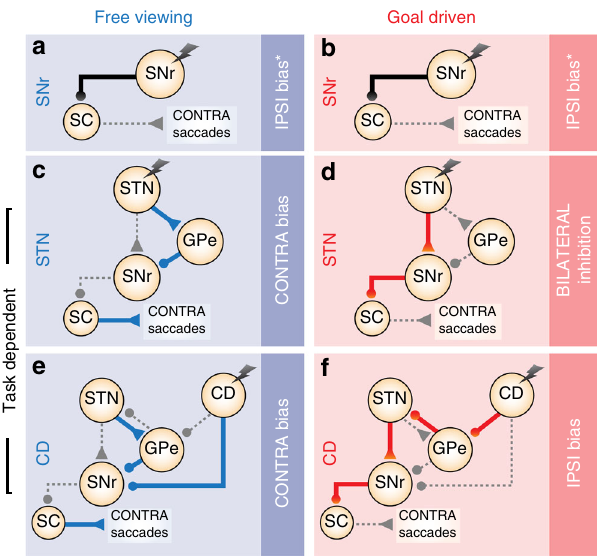
Fig. 6 Hypothesized state of BG connectivity between spontaneous and anti-saccade conditions. a , b SNr stimulation either inhibits contraversive saccades (i.e., ipsiversive bias) *or inhibits saccades bilaterally, regardless of free viewing or anti-saccade task condition. c – f Both the STN and the caudate nucleus (CD; previously electrically stimulated using the same saccade tasks, stimulation protocols, and monkeys 15 activate the SNr during anti-saccades (red), but inhibit the SNr during free viewing saccades (blue), supporting concerted task-dependent changes across the BG circuit, such that faciliatory subthalamo-pallidal-nigral and striato-nigral “ direct ” pathways predominate during unconstrained (free reward) free viewing, while inhibitory subthalamo-nigral “ hyperdirect ” and striato-pallidal-nigral “ indirect ” pathways predominate during goal-directed anti-saccades. Circular and triangular endpoints re fl ect inhibitory and excitatory